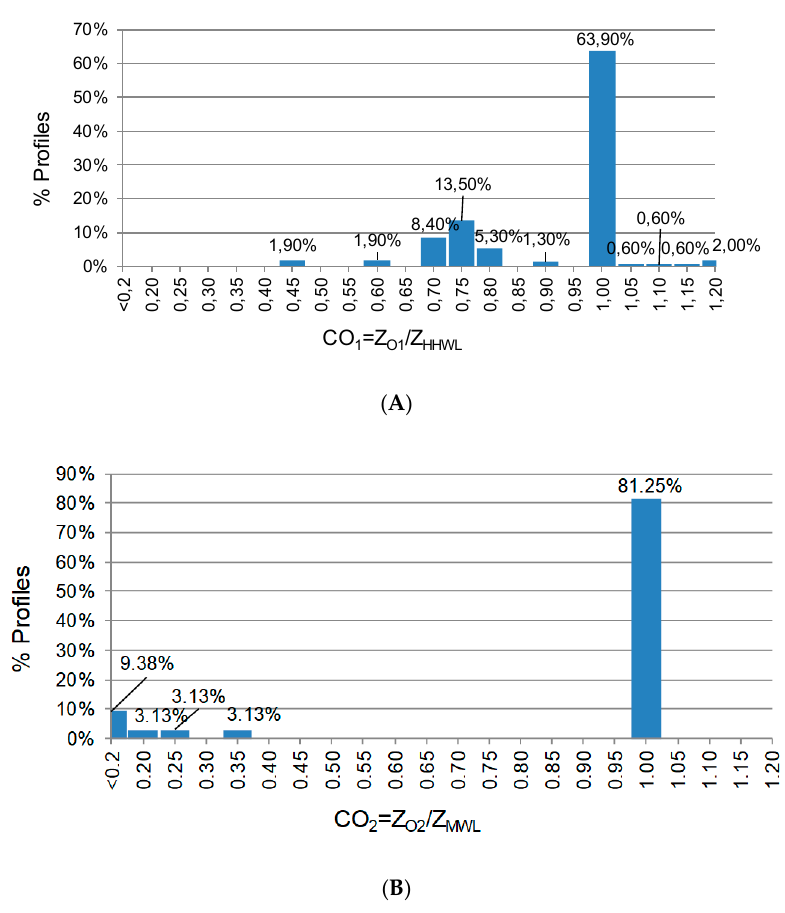
Figure 4. Coefficient (CO 1 ) of the origin (O 1 ) of the emerged parabola with respect to the HHWL for mono-parabolic and bi-parabolic profiles ( A ); and Coefficient (CO 2 ) of the origin (O 2 ) of the submerged parabola with respect to the MWL for bi-parabolic profiles only ( B ).